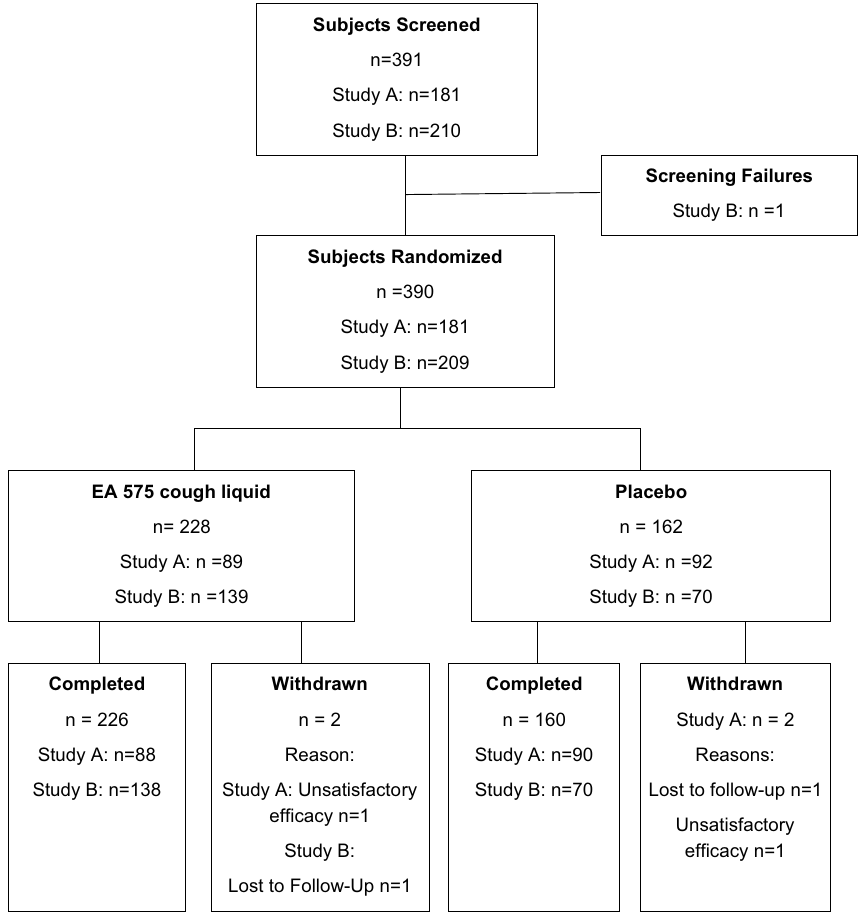
Figure 1. Disposition of patients.